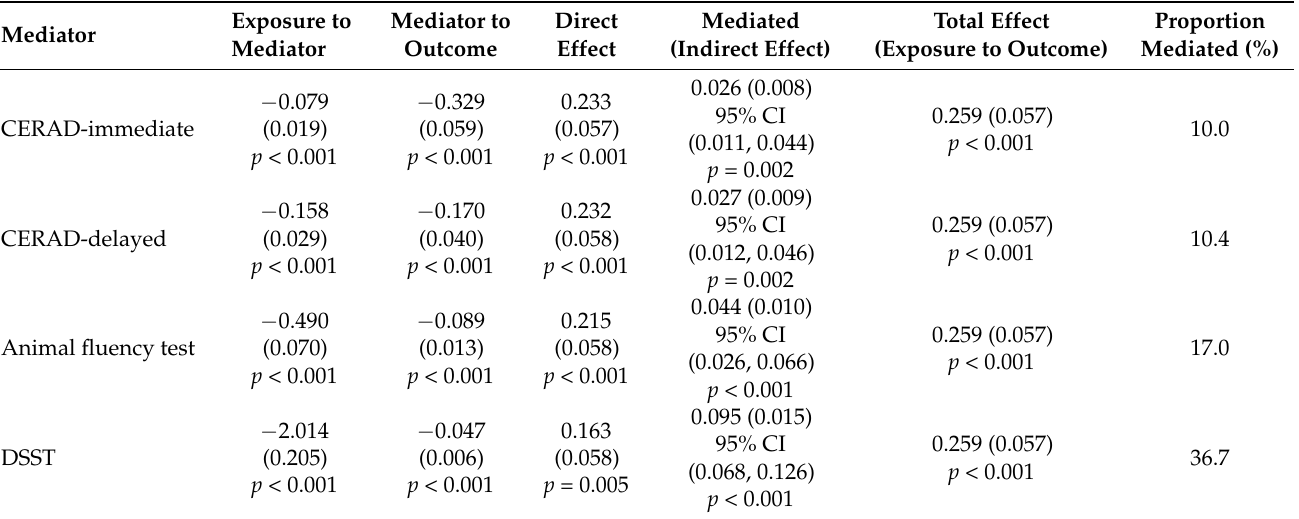
Table 4. Mediation effect of the four dimensions on the association between DII and depressive symptoms scores ( β (SE) and P /95%